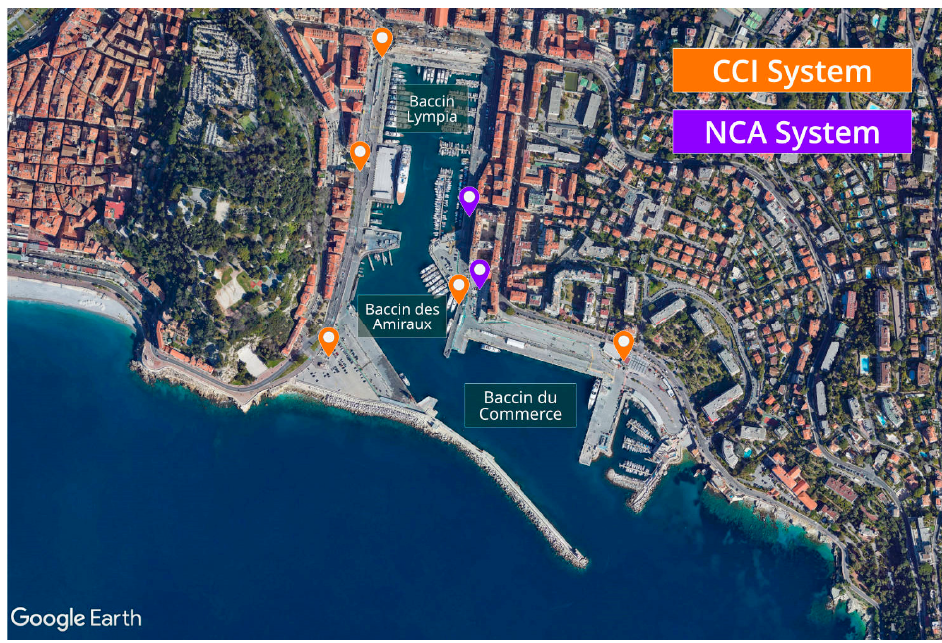
Figure 4. Positioning of the Nice monitoring systems sound level meters. Table 3. The monitoring systems in the North Tyrrhenian Sea.